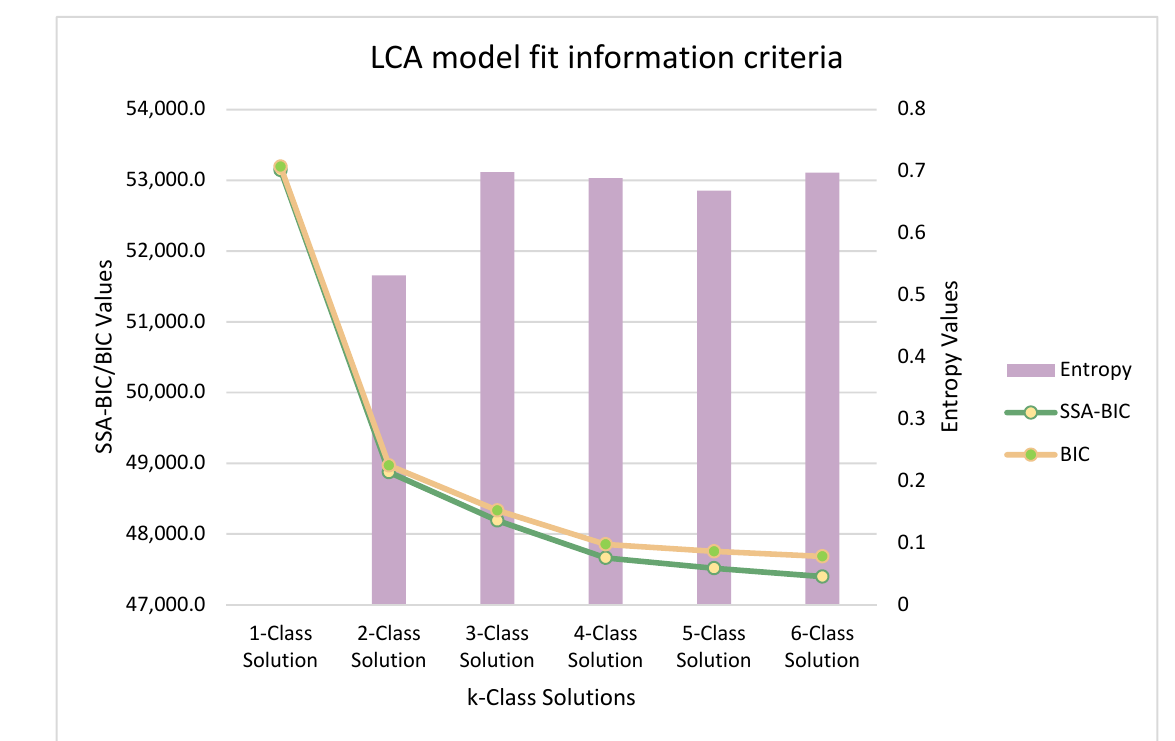
Figure 1. Fit model criteria.